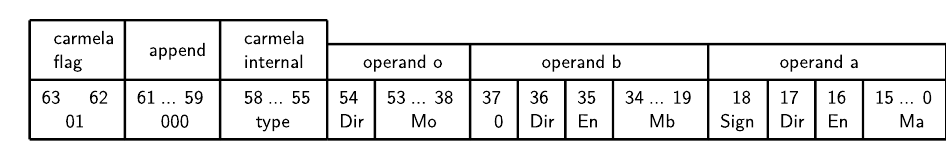
Figure 14: Instruction template for the coprocessor Carmela .